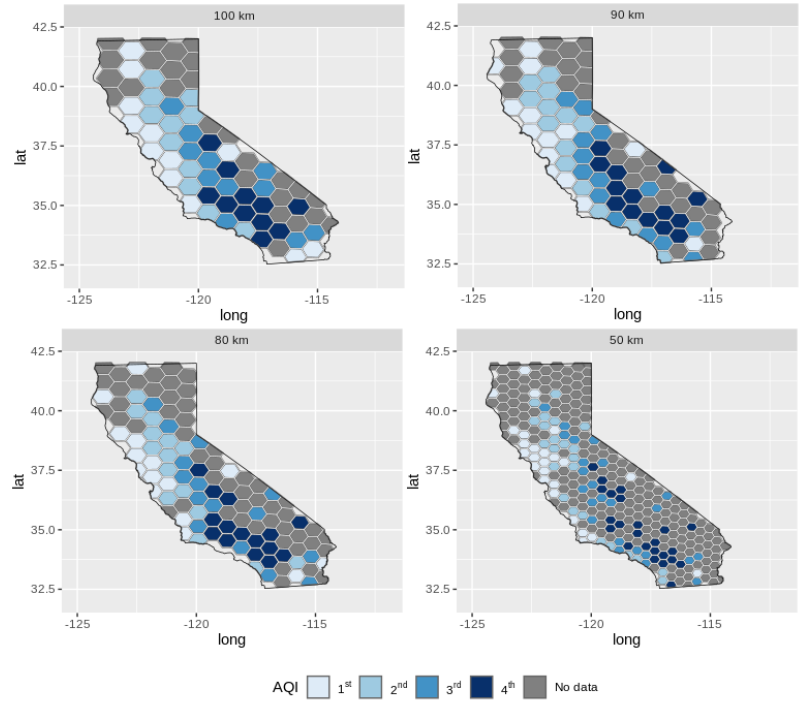
Figure 9. Comparison of spatial patterns of Pareto-optimal areal units with other arbitrary areal units in the state of California. The patterns correspond to the ‘odds ratio measure’ of the frequency of geographic coordinates O 3 data